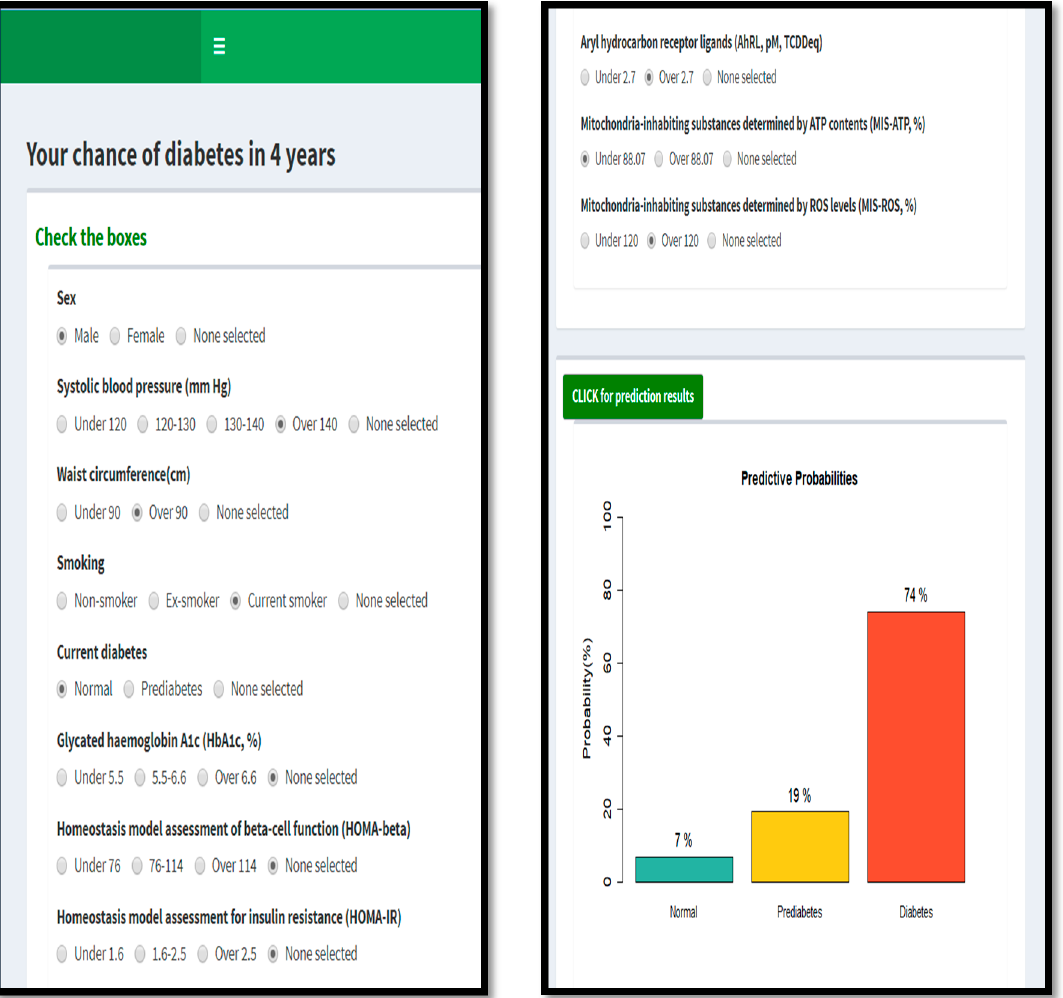
Figure 4. An illustration of DiabetesBN [32], the online interactive app that implements the BN prediction model for diabetes progression. This is an example of the predictive probabilities of normal (NGT), prediabetes (IGT), and diabetes (DM) in 4 years for a subject with Sex = male, Waist ≥ 90 cm, sysBP ≥ 140 mm Hg, Smoke = current, cGTOL = NGT, AhRL ≥ 2.7, MISATP < 88.07, and MISROS ≥